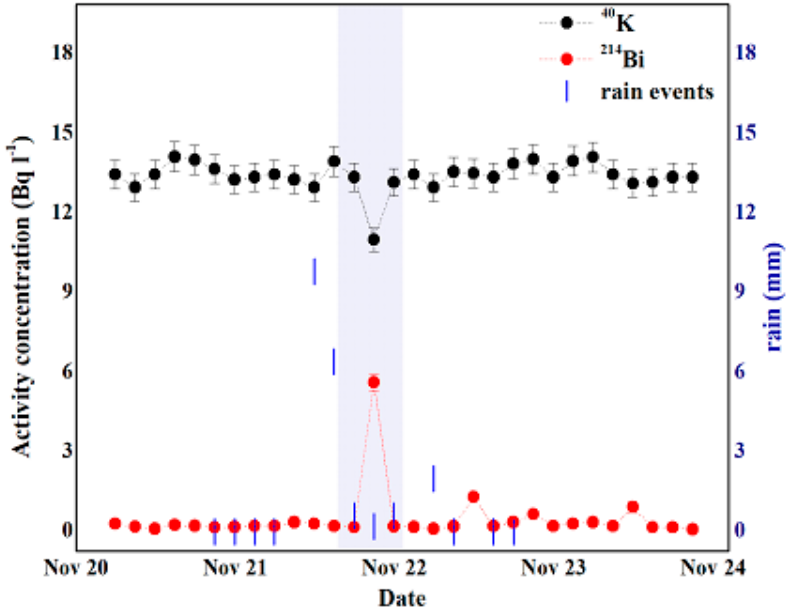
Figure 6. The activity concentration of 40 K and 214 Bi for the measuring period (the vertical lines represent the rainfalls).